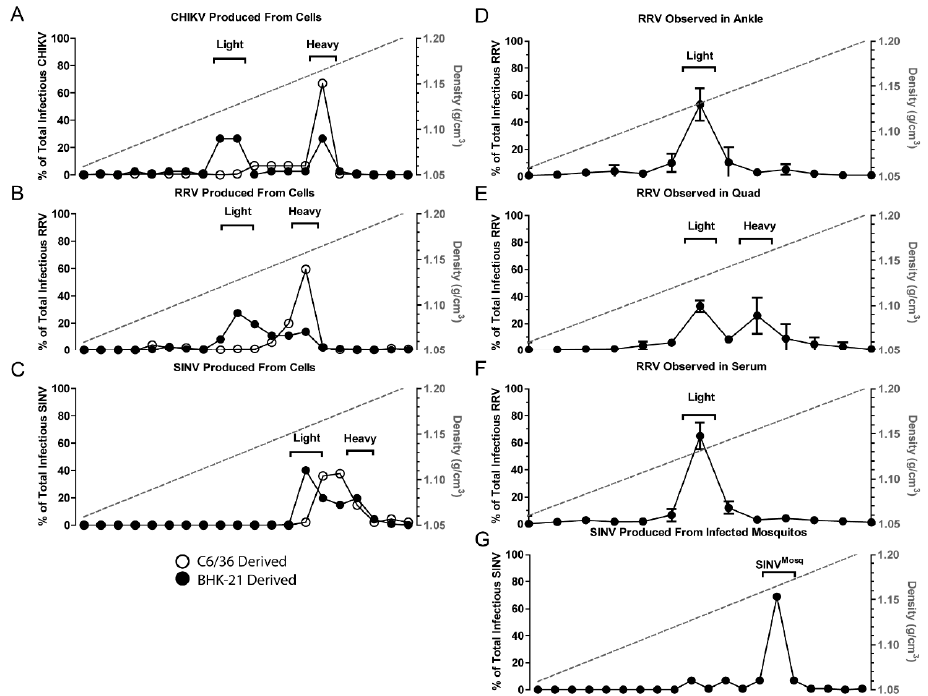
Figure 1. Host type affects virus subpopulations. Purified virus particles were separated into subpopulations by centrifuging in a 15–45% sucrose gradient. Fractions of the gradient were then assayed for infectious units. ( A – C ) Virus particles derived from BHK-21 cells (closed circles) exhibit two populations termed Light and Heavy. Particles derived from C6/36 cells (open circles) only exhibit one population; ( D – F ) RRV extracted from the indicated mouse tissues one day post-subcutaneous injection; ( G ) SINV extracted from A. aegypti mosquitoes one day post-intrathoracic injections. Panel C is adapted from [27]